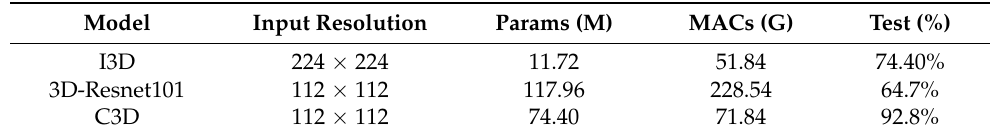
Table 5. Comparison of different feature extraction